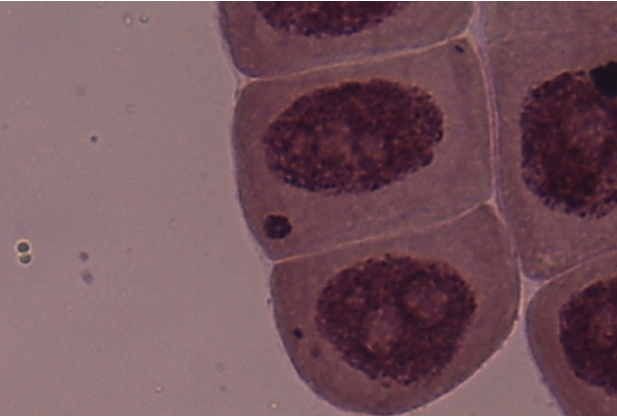
FIGURE 2 - Micronucleus in interphase.